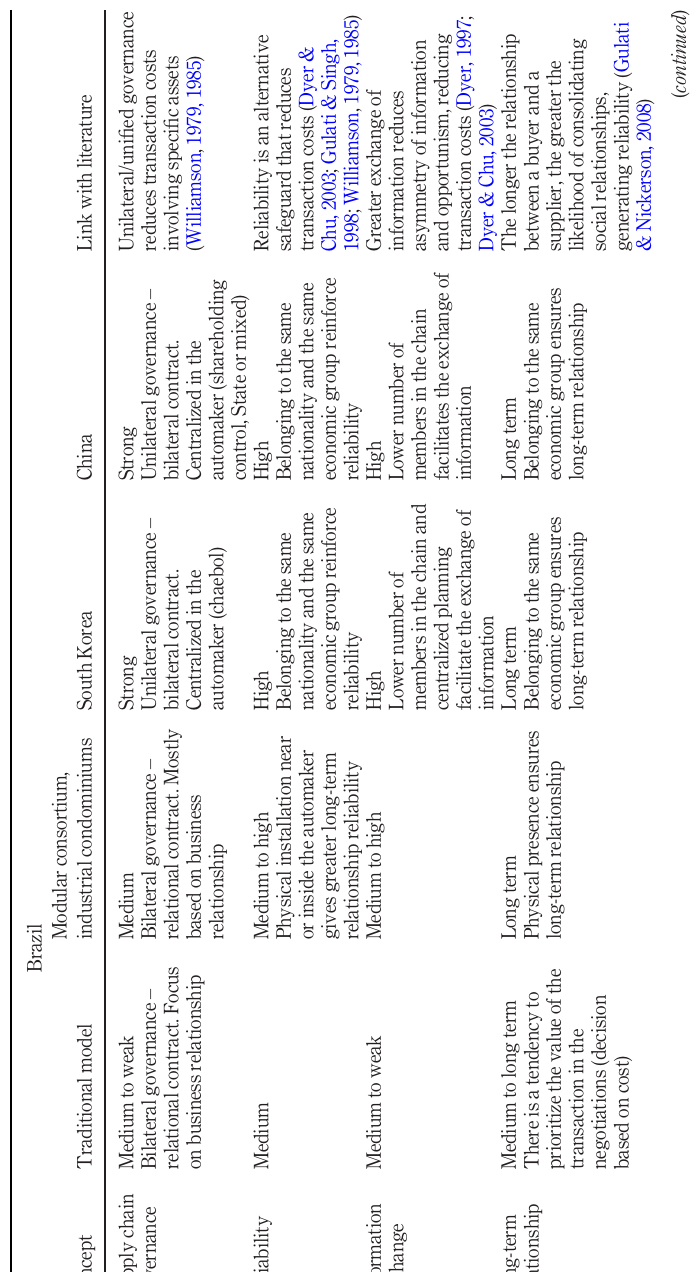
Table V. Findings from the